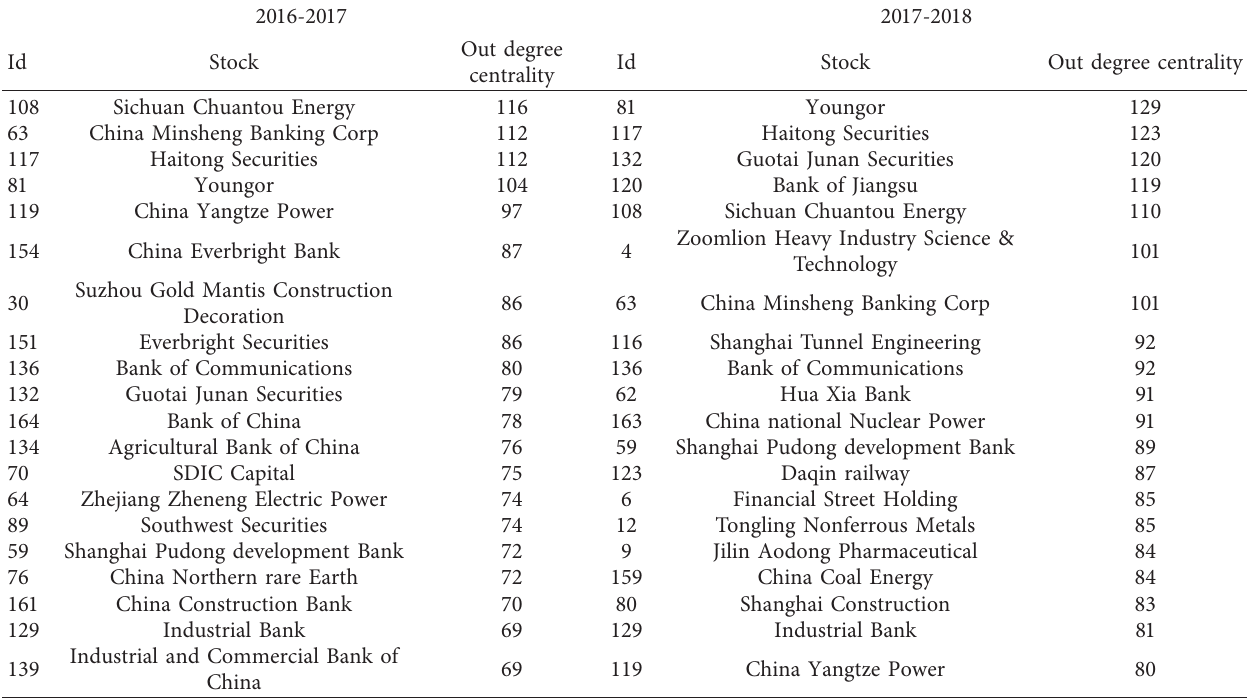
Table 5: Top 20 out degree centrality stocks of CSI 300 network in 2016-2017 and 2017-2018.